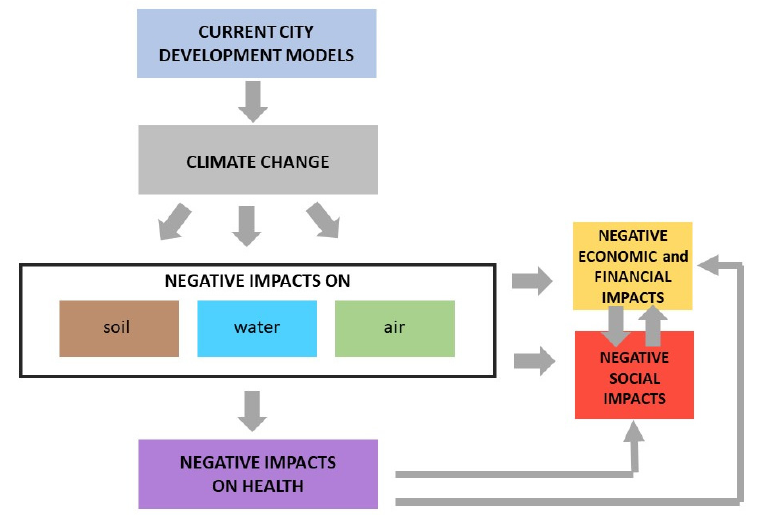
Figure 1. Climate change and related negative impacts.